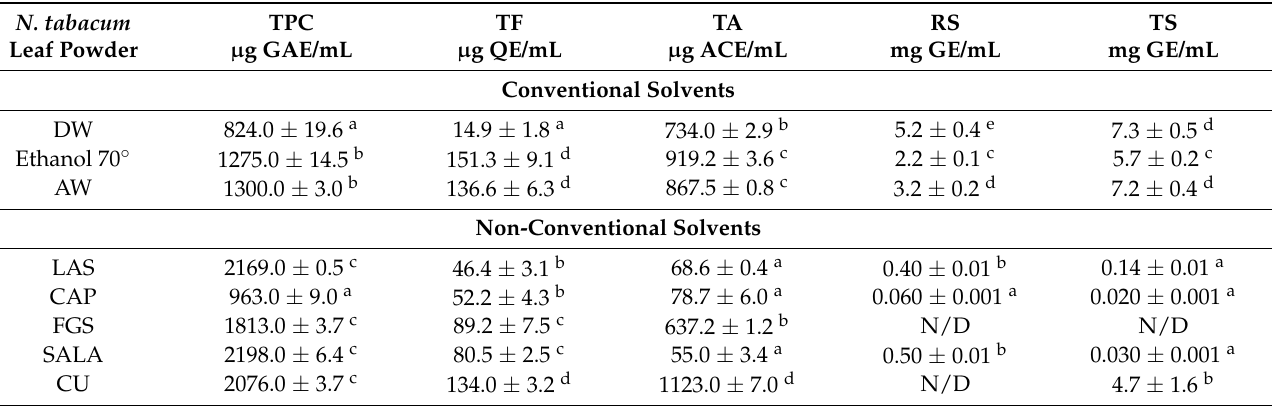
Table 4. Phenolic compounds, total flavonoids, total alkaloids, reducing sugar and total sugar content of Nicotiana tabacum var. Virginia leaf waste powder extracts by using conventional and non-conventional